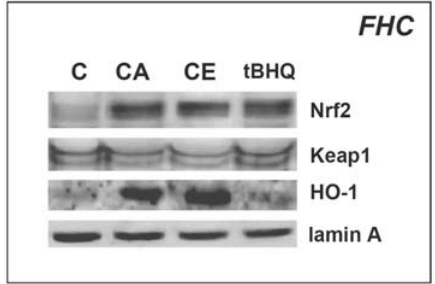
Figure 5. Upregulation of Nrf2 and HO-1 protein levels in normal human fetal epithelial colon cells exposed to cinnamic aldehyde and ethanolic cinnamon extract. FHC cells were treated with either CA (10 µM), CE (dose CA: 10 µM), or tBHQ (100 µM) for 4 h. Equal loading was assessed by immunodetection of lamin